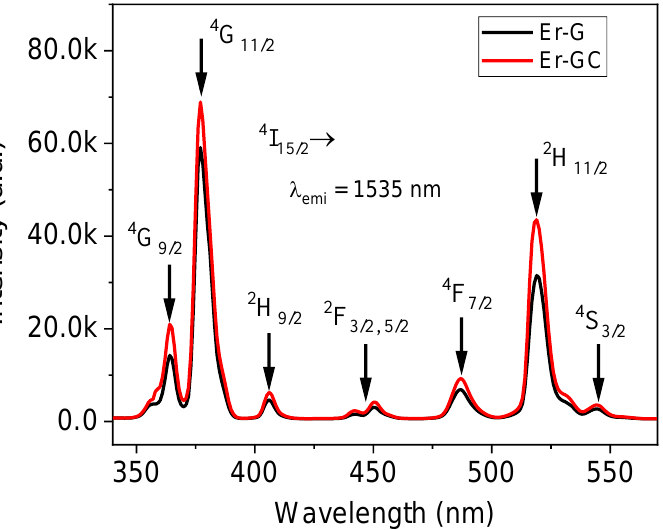
Figure 6. Photoluminescence excitation spectra (PLE) of Er-G and Er-GC measured under emission wavelength 1535 nm.